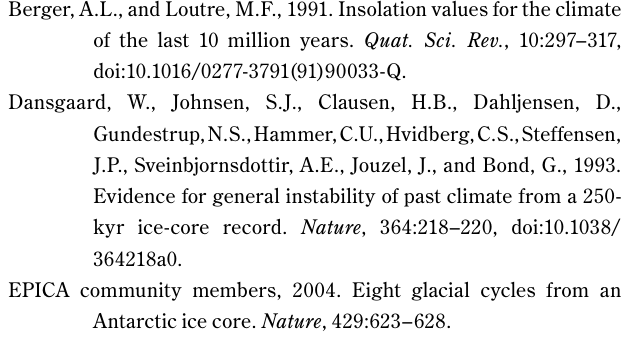
Fig. 1. Bathymetry and elevation taken from the GEBCO digital atlas (IOC, IHO, and BODC, 2003). Fig. 2. Photo by Ulrich C. Müller. Fig. 4. Photo by Ulrich Kotthoff.